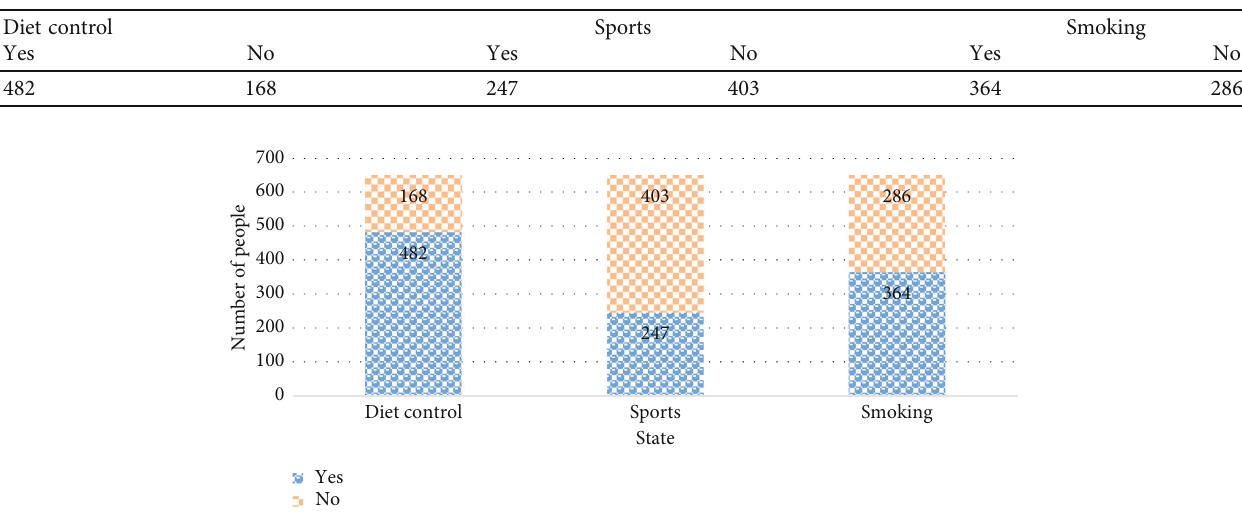
Figure 3: The patient ’ s life status.